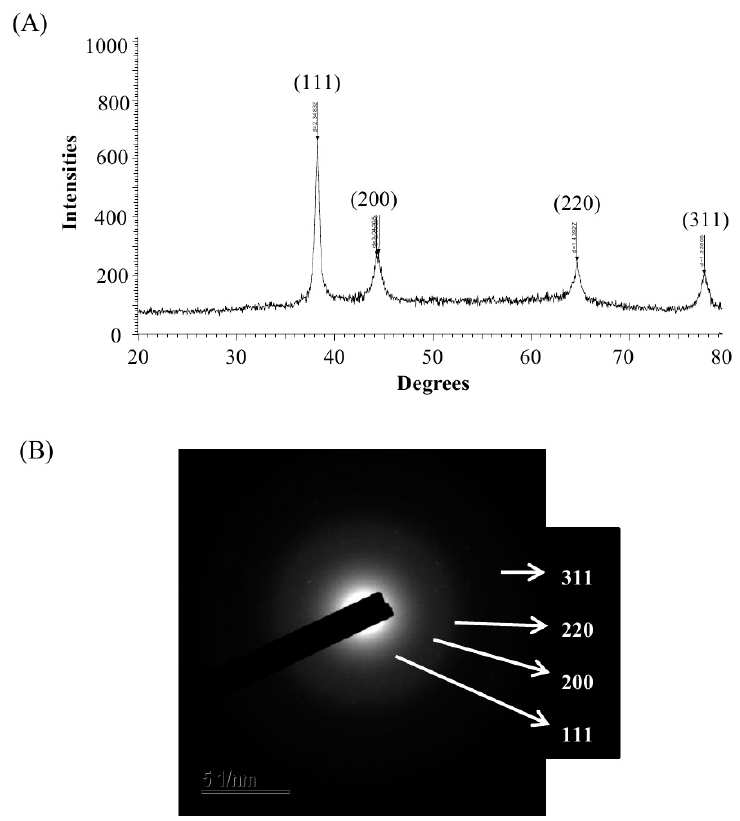
Figure 4. X-ray di ff raction pattern ( A ) and elemental mapping and selected area di ff raction (SAED) Figure 4. X-ray diffraction pattern ( A ) and elemental mapping and selected area diffraction (SAED) pattern ( B ) of synthesized pattern ( B ) of synthesized AgNPs.